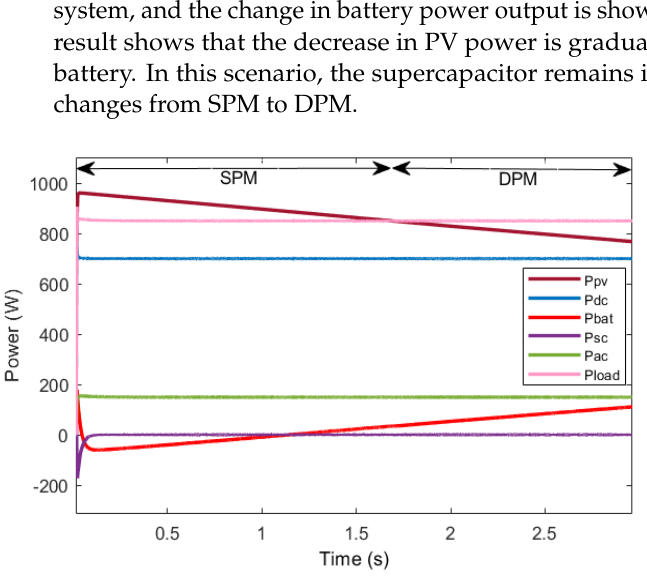
Figure 11. PV, DC load, AC load, supercapacitor, and battery power for a smooth change in irradi- ance.